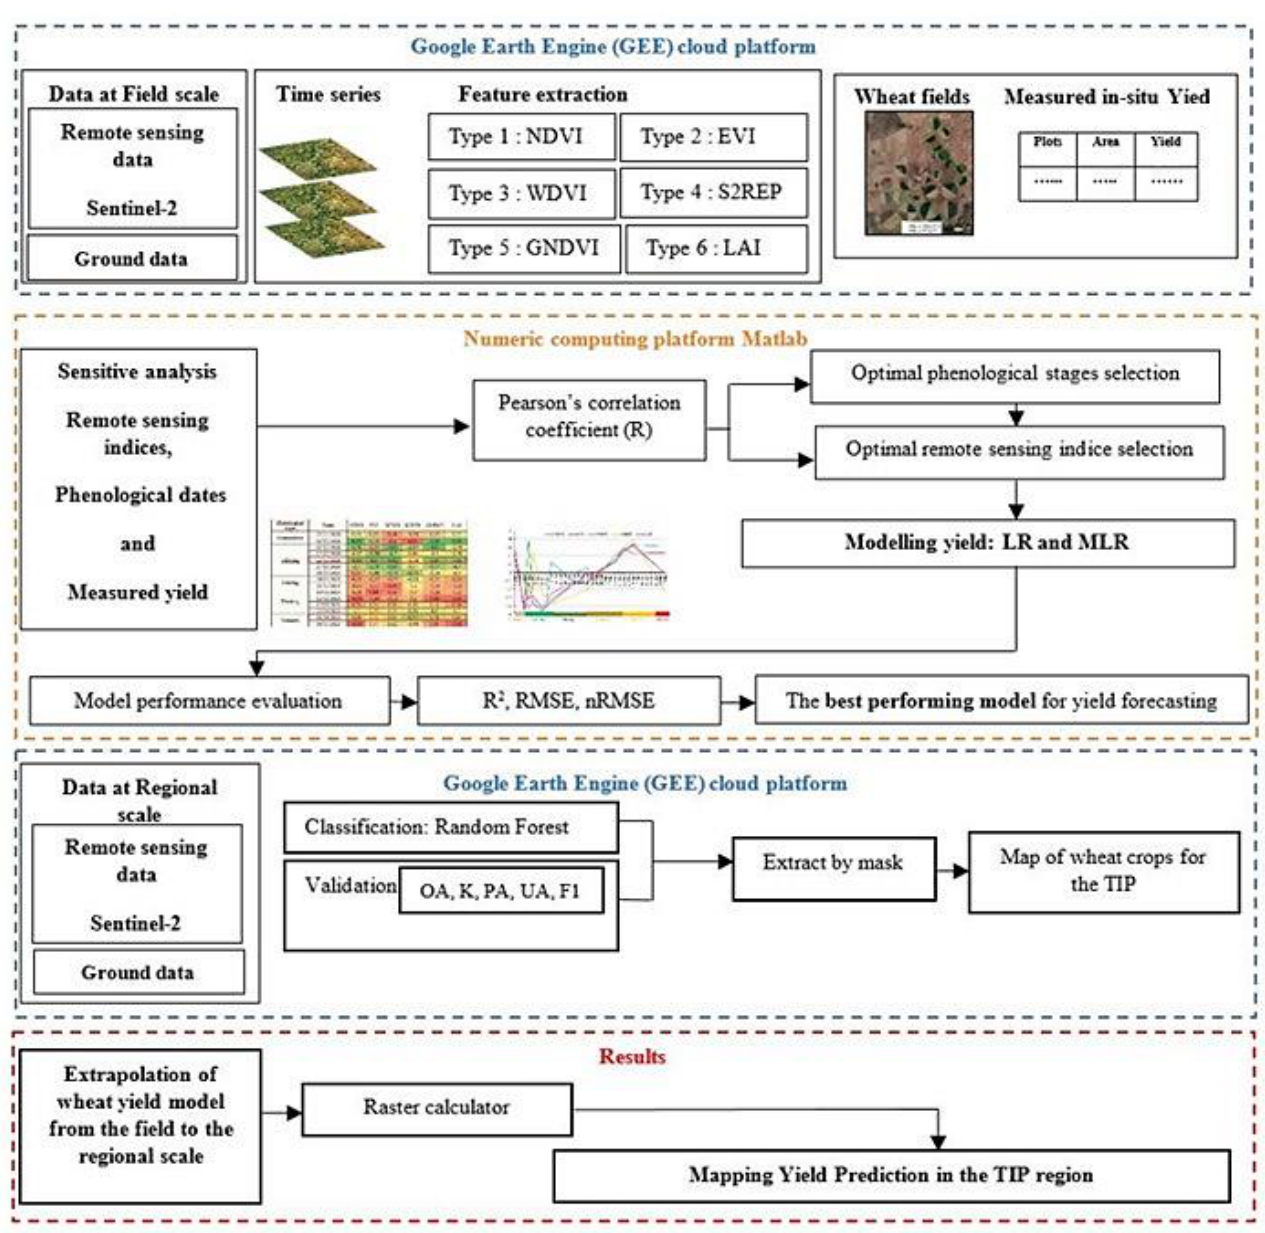
Figure 2. Flowchart of the proposed method for wheat yield estimation using LR, MLR, and Google Earth Engine.